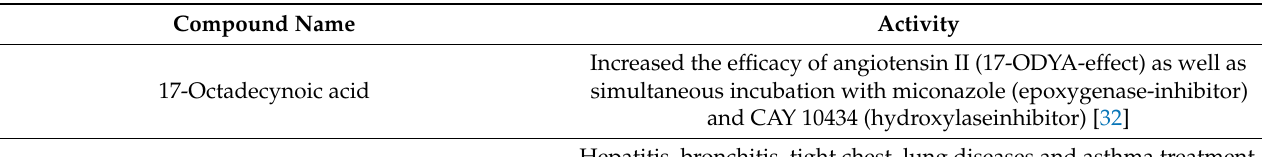
Table 6. Activities of some VOCs emitted from S. arghel extractions (EtAoH and